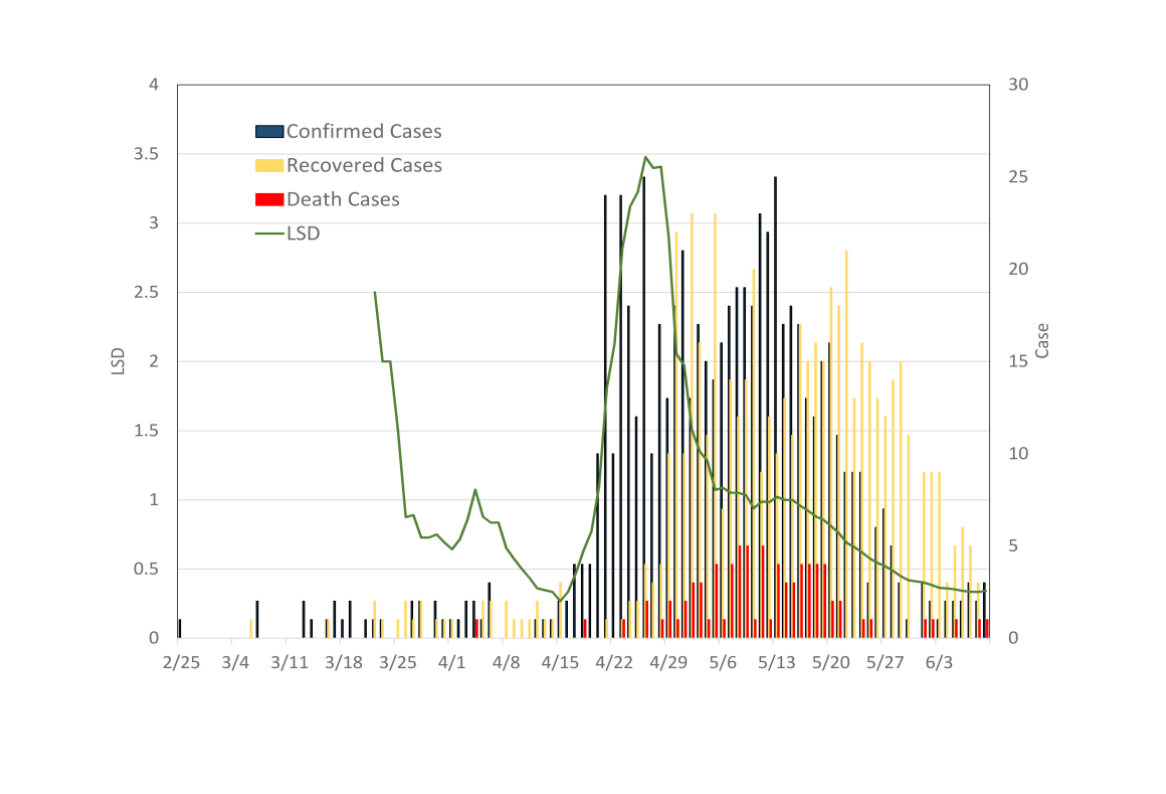
Figure 5. LSD index for severe acute respiratory syndrome outbreak in Taiwan, 2003. The 2.5 LSD index was high on March 22, 2003, at the initial epidemic stage then decreased to 0.3 on April 15, 2003. After April 22, the LSD index started increasing from 1 by nosocomial infection. The lower LSD index (<0.5) indicated that social distancing could have been lifted at the end of May. LSD: lifting social